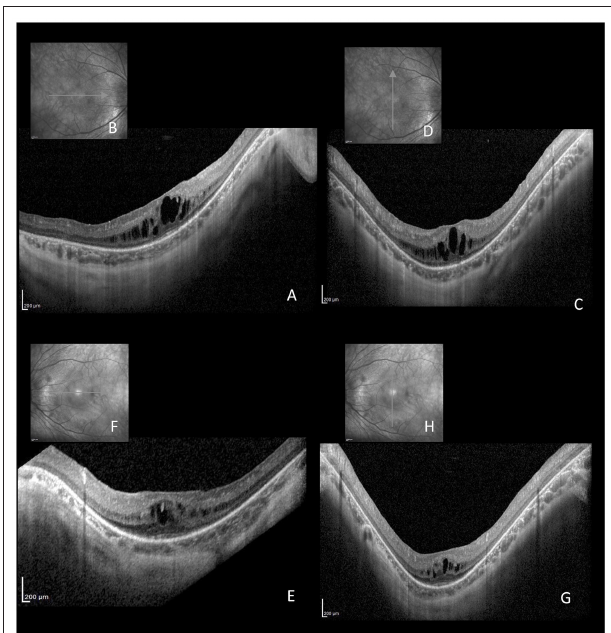
FIGURE 2 | Horizontal (A,B,E,F) and vertical (C,D,G,H) linear SD-OCT passing through the fovea of the same patient affected by CDG-Ia. Cystoid macular edema with foveal and perifoveal retinal thickening, intraretinal cysts, retinoschisis, and absence of the retinal outer segment, outside the fovea, are